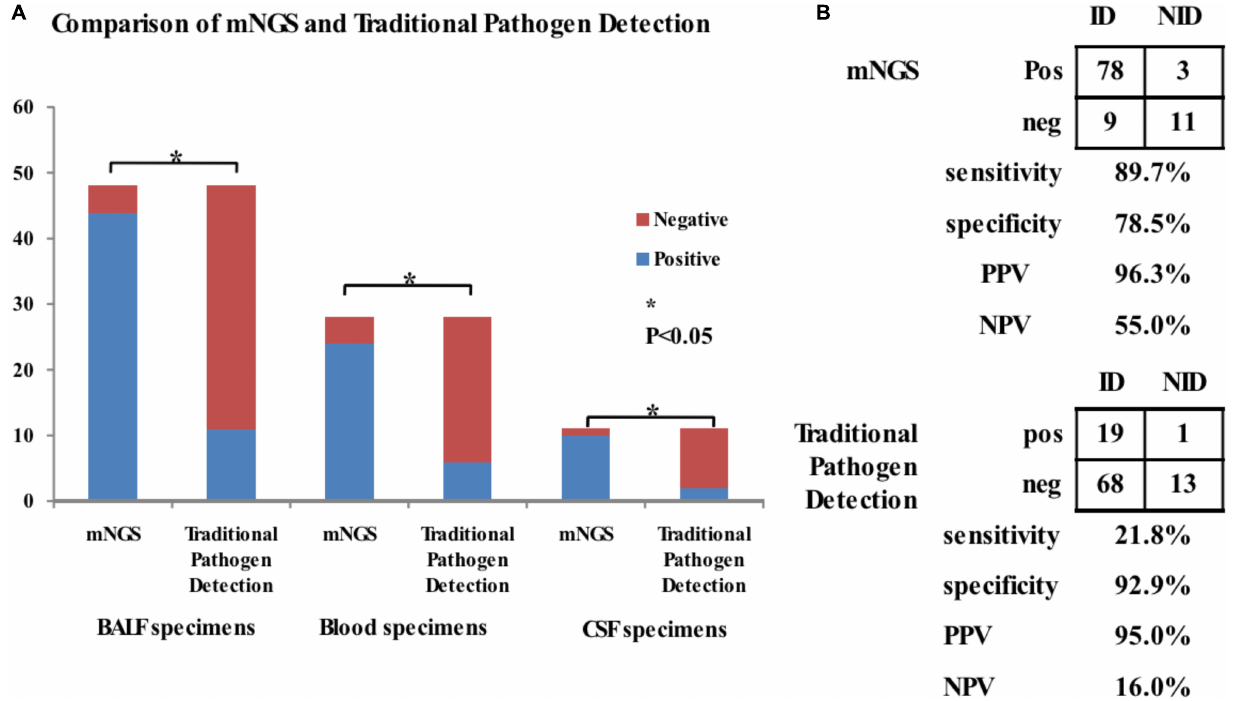
FIGURE 2 | Comparison of positive rates between mNGS and traditional pathogen testing for detection pathogens in BALF ( n = 48), blood ( n = 28), and CSF ( n = 11) samples. (A) The sensitivity of mNGS was compared to that of traditional pathogen detection methods for diagnosis of pulmonary infections, bloodstream infections or viremia, and CNS infections in children recipient. The sensitivity of mNGS for diagnosing pulmonary infections, bloodstream infections or viremia, and CNS infections post-transplant were 91.7, 85.7, and 90.9, respectively. In contrast, the sensitivity of conventional testing for diagnosing pulmonary infections, bloodstream infections or viremia, and CNS infections post-transplant were 22.9, 21.4, and 18.2, respectively. There were significant differences in the sensitivity of mNGS and conventional testing in BALF, blood, and CSF samples, with P -values of 0.000, 0.000, and 0.002, respectively. (B) The sensitivity and specificity of mNGS were compared to traditional pathogen detection methods for diagnosis of infections in post-transplant children. mNGS was more sensitive (89.7%) compared to conventional pathogen detection (21.8%), with a difference of 67.9% ( P < 0.001), However, mNGS was less specific (78.5%) than traditional methods (92.9%), with a difference of 14.4% ( P = 0.596). The PPV and NPV of mNGS were 96.3 and 55.0%, respectively. In comparison, the PPV and NPV of traditional pathogen detection were 95.0 and 15.0%, respectively. ∗ P <